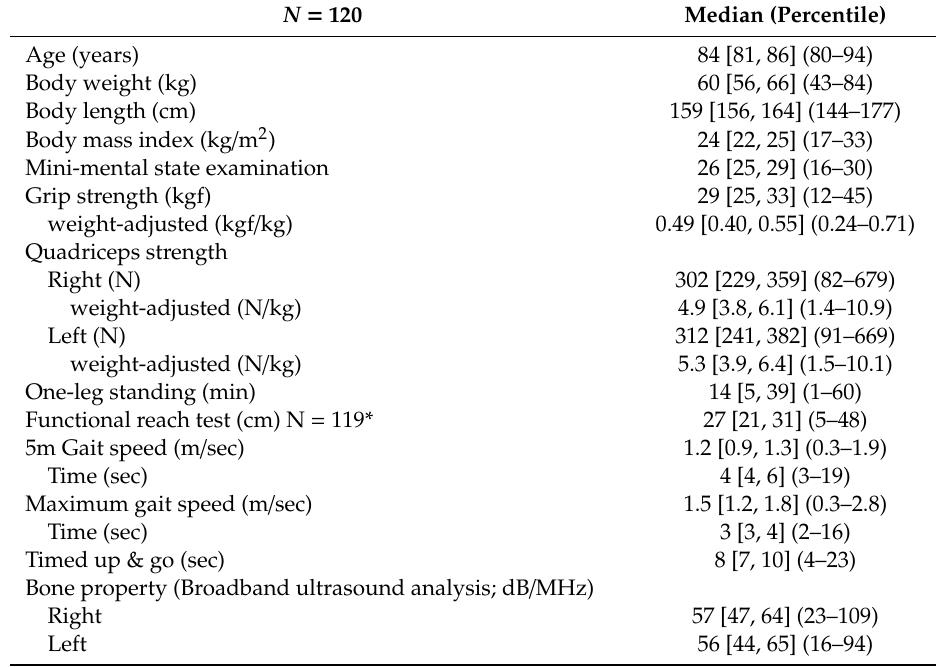
Table 1. Patients’ characteristics and physical performance measurements among Japanese men aged 80 years or